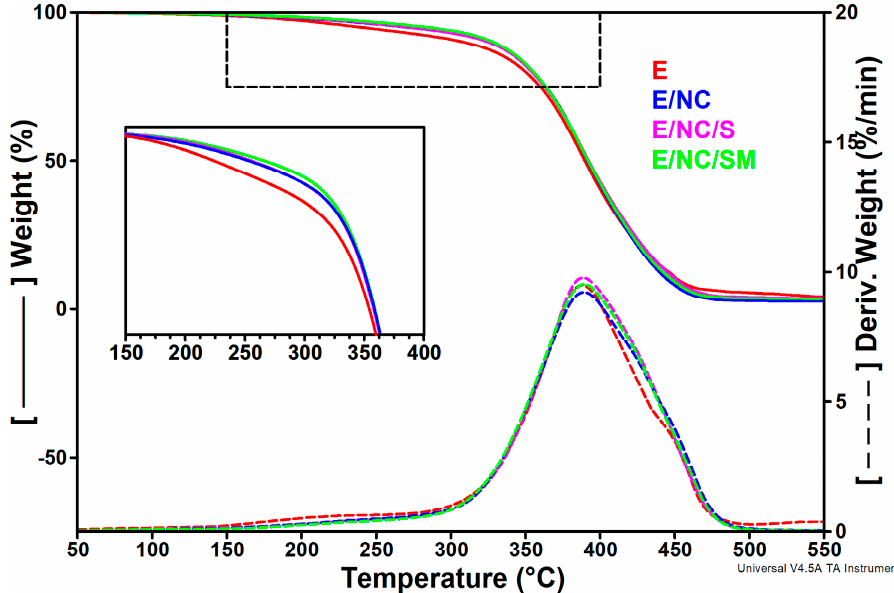
Figure 4. TGA, DTG and inset from 150 to 400 ◦ C for the neat epoxy system and epoxy nanocomposites. Table 1. Thermal properties of the ELO epoxy matrix and its nanocomposites with NCs.